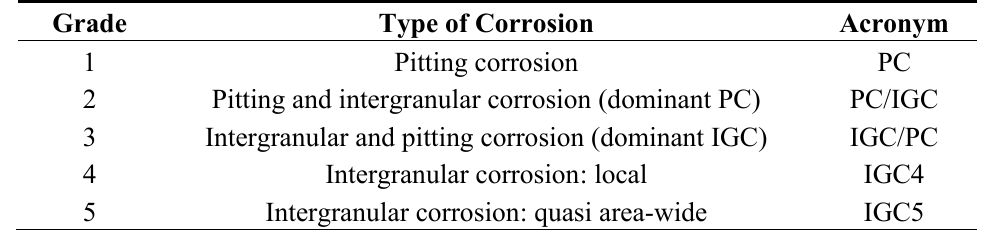
Table 2. Classification of intergranular corrosion. IGC, intergranular corrosion; PC, pitting corrosion. Grade Type of Corrosion Acronym 1 Pitting corrosion PC 2 Pitting and intergranular corrosion (dominant PC) PC/IGC 3 Intergranular and pitting corrosion (dominant IGC) IGC/PC 4 Intergranular corrosion: local IGC4 5 Intergranular corrosion: quasi area-wide